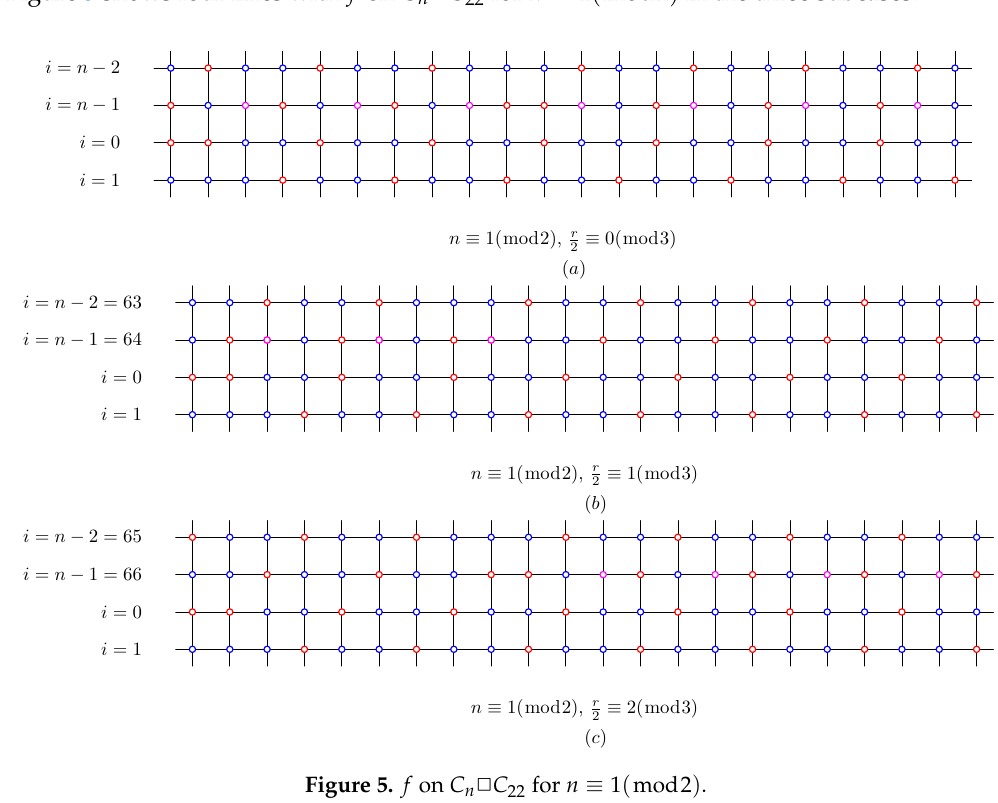
Figure 5. f on C n 2 C 22 for n